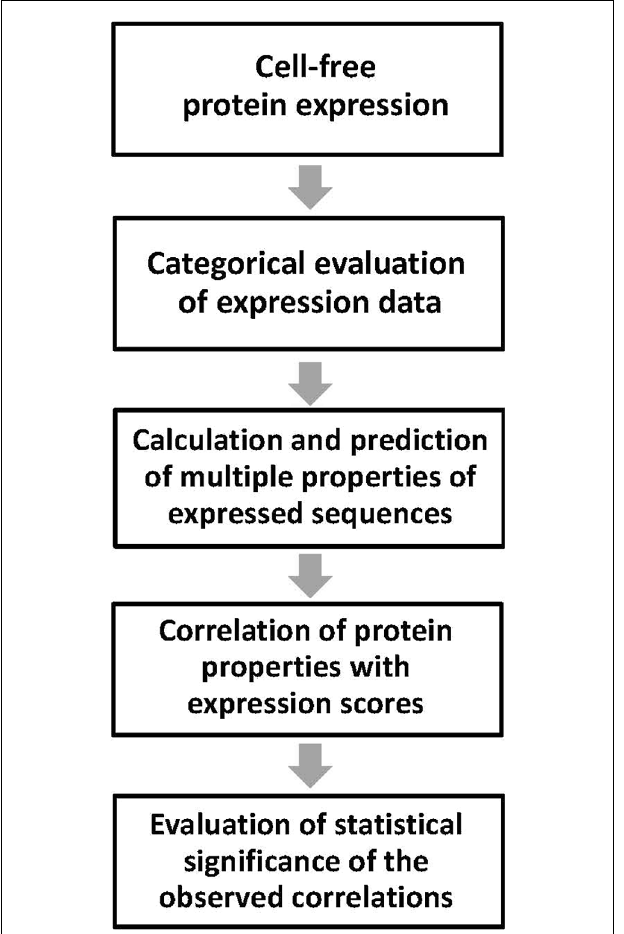
FIGURE 1 |Workflow of the analysis. Main steps of the experimental data processing are presented. Cell-free protein expression should be performed under the same uniform set of conditions.